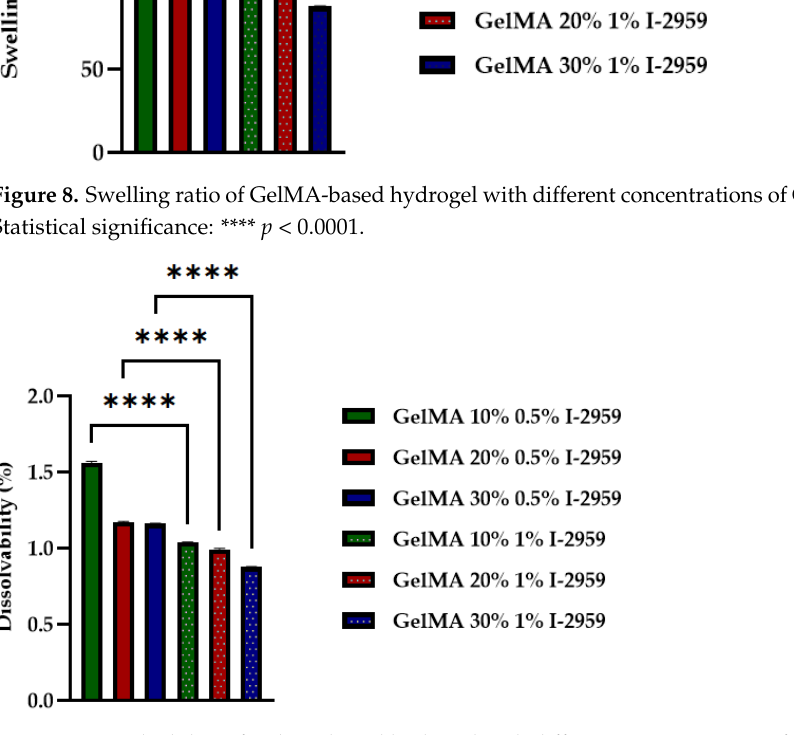
Figure 9. Dissolvability of GelMA-based hydrogel with different concentrations of GelMA and I- Statistical significance: **** p < 0.0001. 2959. Statistical significance: **** p < 0.0001.